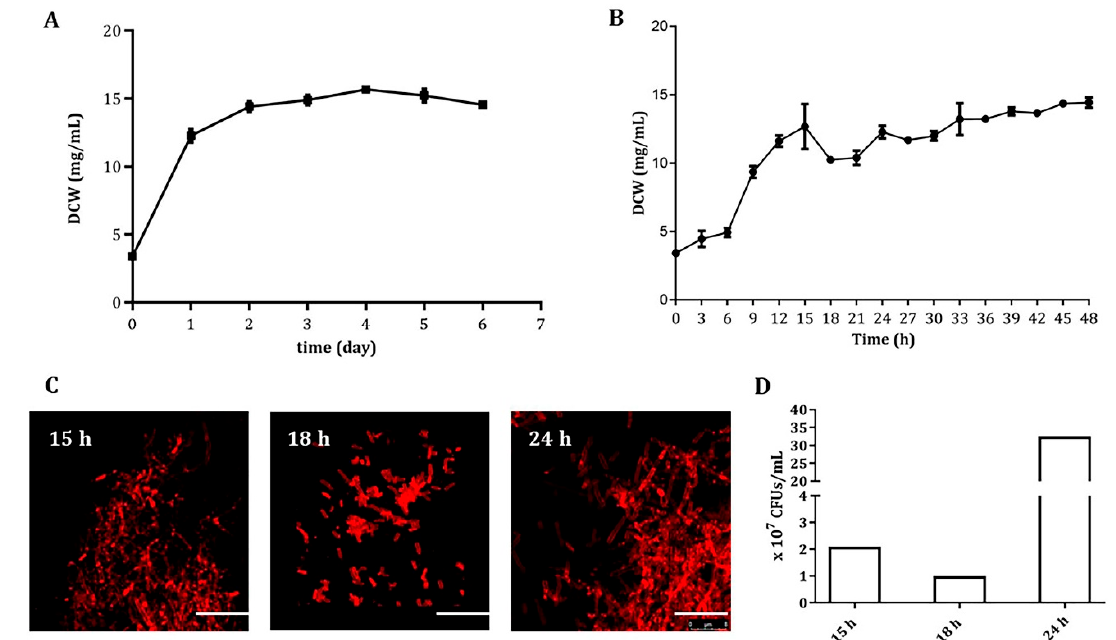
Figure 1. The growth and mycelial fragmentation of A. pretiosum ATCC 31280 in submerged cultures. ( A ) Growth curve of A. pretiosum ATCC 31280 during 6-day fermentation. Samples were taken daily. Error bars: mean ± standard deviation (SD; n = 3 biological replicates); ( B ) Growth of A. pretiosum ATCC 31280 during the first 48-h fermentation. Samples were taken every 3 h. Error bars: mean ± SD ( n = 3 biological replicates); ( C ) Confocal micrographs of A. pretiosum ATCC 31280 at 15, 18 or 24 h. Scale bar: 10 µ m. Magnification, 2500 × ; ( D ) Colony forming units (CFUs) of cultures at 15, 18 or 24 h.